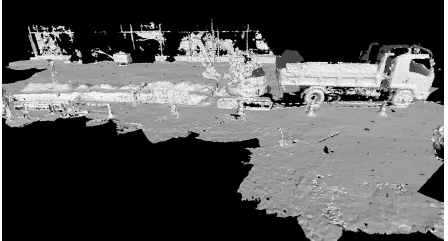
Figure 1. 3D measurement result using a TOF camera in a construction